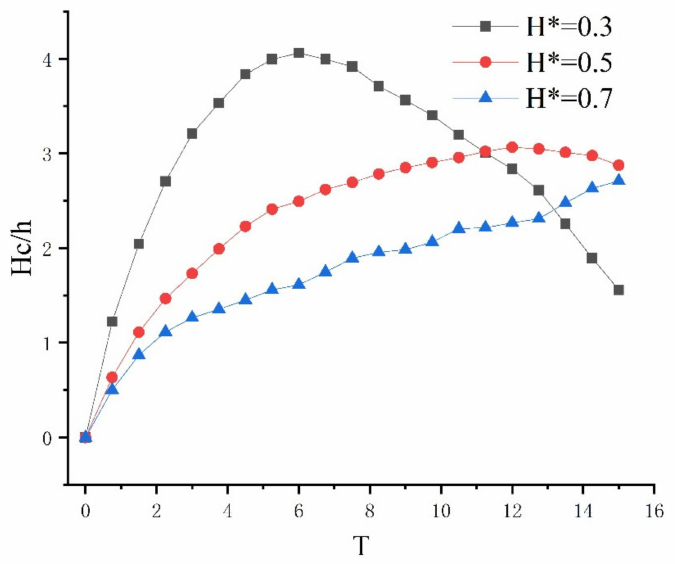
Figure 11. The dimensionless crown height changing with dimensionless time under different H*.